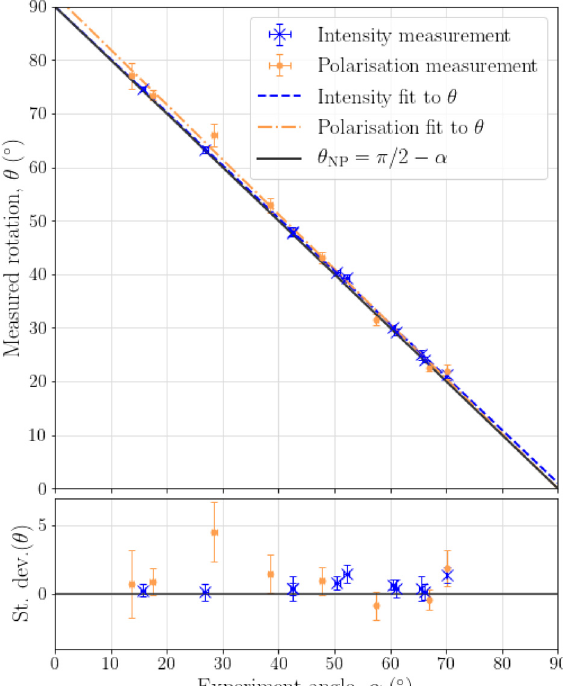
Figure 3: Image and polarisation rotation for non-planar trajectories: experimental measurements and theoretical prediction of the relationship between non-planarity set by 𝛼 and the intensity rotation 𝜃 . The lower plot shows the difference between the measured 𝜃 and the theoretically expected 𝜃 estimated to be smaller than 0 . 5 ◦